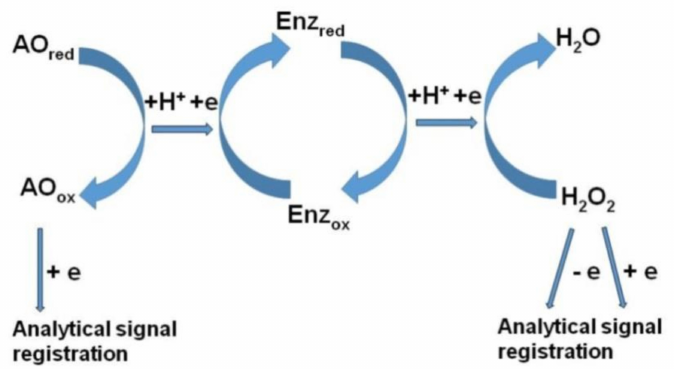
Figure 7. The scheme of amperometric response of peroxidase-based biosensors to compounds with antioxidant properties or to hydrogen peroxide (Enz—enzyme,